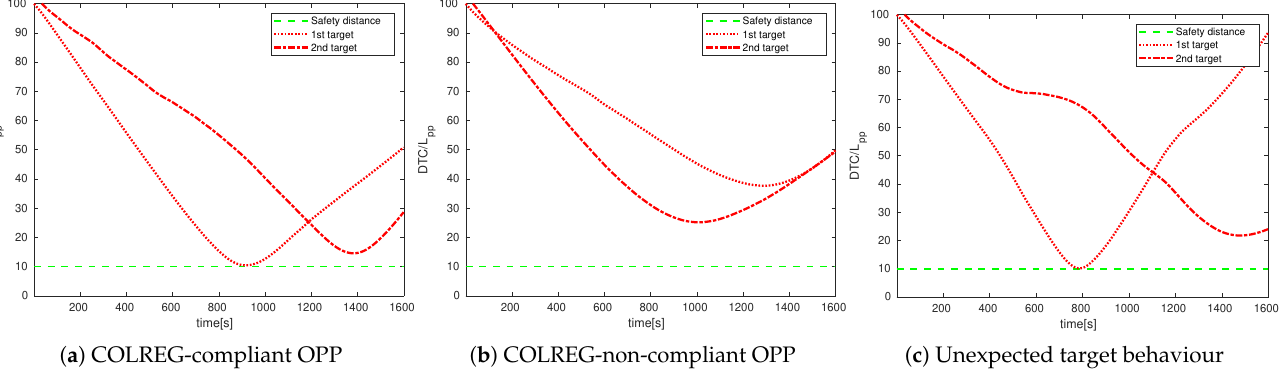
Figure 10. Scenario 1: DTC during the simulation of a COLREG-compliant manoeuvre ( a ), COLREG non-compliant manoeuvre ( b ) and COLREG-compliant manoeuvre with unexpected target behaviour ( c